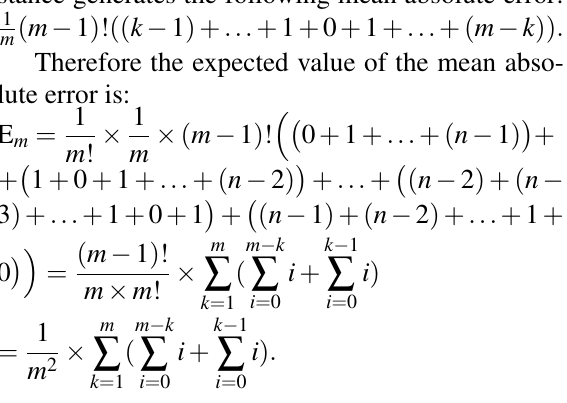
Table 2: Preference with level of dominance vs. binary preference — mean absolute error with support vector classifier with Radial Basis Function Kernel (RBFK) and Normalised PolyKernel (NPK)